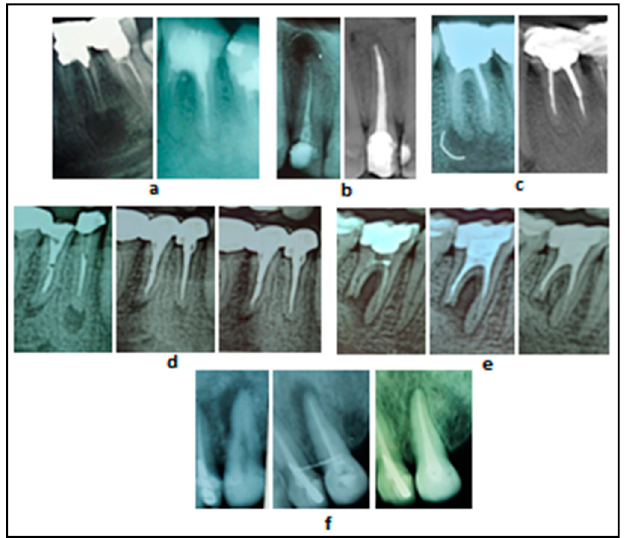
Figure 2. Radiographs of apical periodontitis cases from the Cupral group. ( a ) Female, 25-years old,